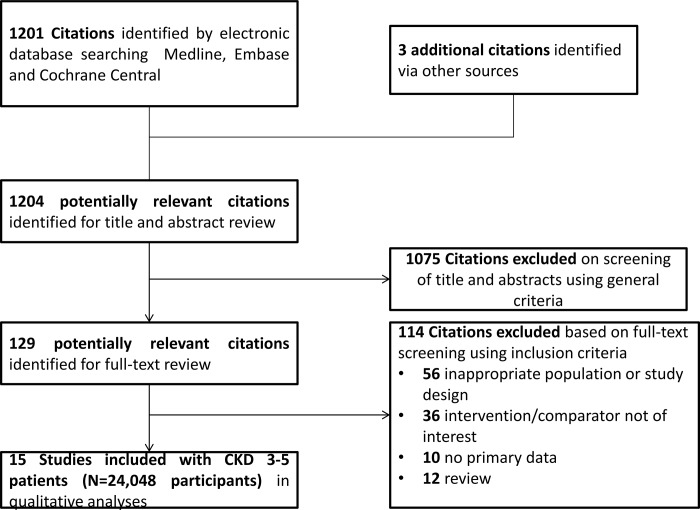
Selection and description of studies.